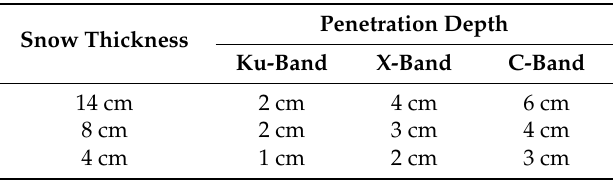
Table 5. Modeled Ku-, X- and C-band penetration depths (from air/snow interface) (Equation (4)) from the 14 cm, 8 cm and 4 cm snow covers on FYI, acquired on 19 May 2012. Penetration Depth Snow Thickness Ku-Band